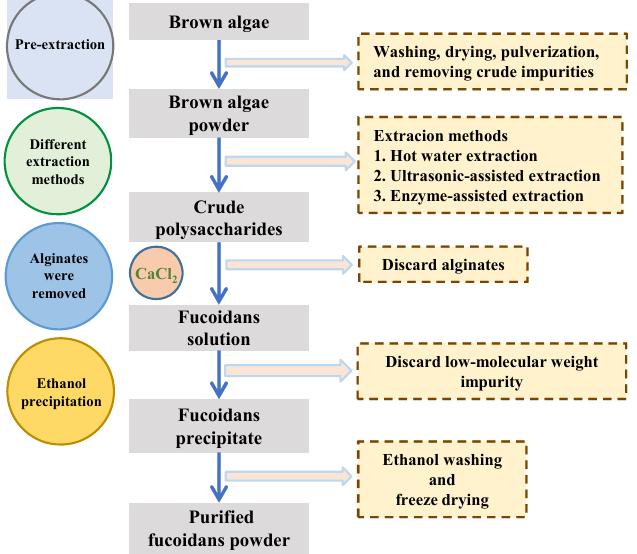
Figure 2. Schematic diagram of the extraction and preparation of fucoidan from brown algae.